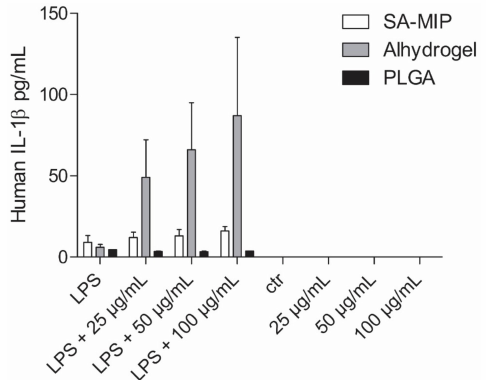
Figure 3. Secretion of Il-1 β after incubation with SA-MIPs, Alhydrogel and PLGA. THP-1 cells were either primed with LPS 1 µ g/mL for 4 h at 37 ◦ C or incubated with cell culture medium alone before the cells were harvested and incubated with 0 µ g/mL, 25 µ g/mL, 50 µ g/mL or 100 µ g/mL SA-MIPs, Alhydrogel or PLGA. Media from the incubations were collected after 24 h and the content of IL-1 β was analyzed using ELISA. The left part of the graph shows THP-1 cells primed with LPS, and the right part is the unprimed control. The results represent the mean of three independent experiments ±